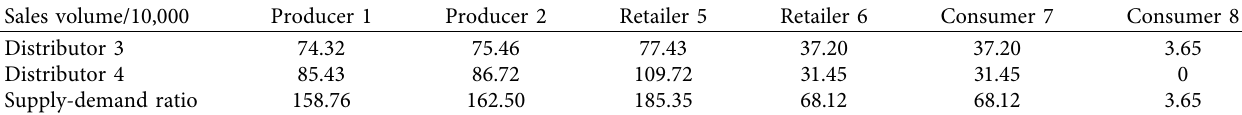
Table 7: Green product sales volumes in the GSCDN under government subsidy.